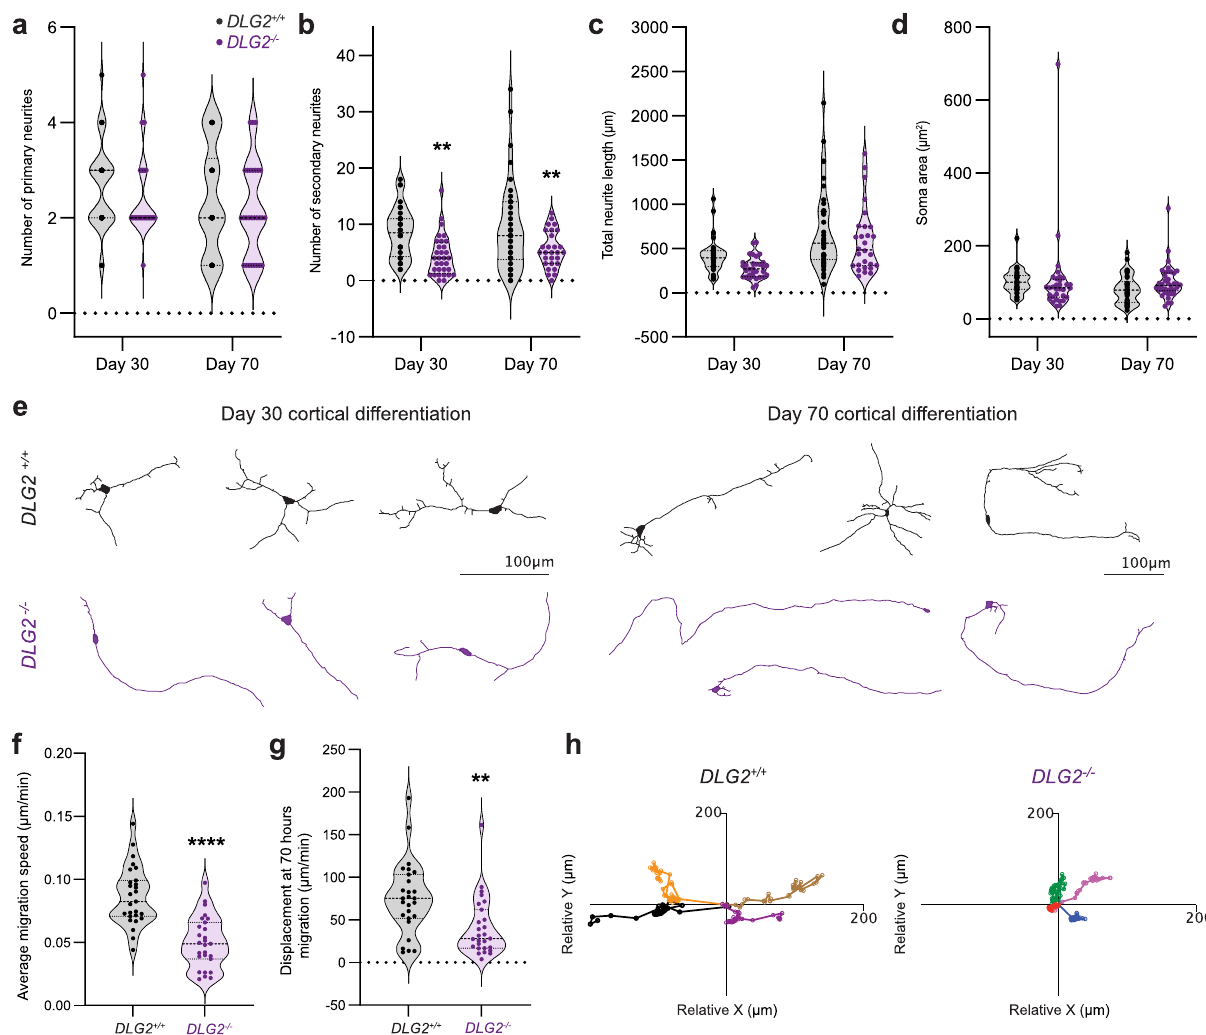
Fig. 3 DLG2 − / − lines display de fi cits in neuron morphology & migration. a The number of primary neurites (projecting from the soma). Neither genotype ( F 1,126 = 1.591; P = 0.2095) nor time ( F 1,126 = 2.278; P = 0.1337) had signi fi cant effects the numbers of primary neurites. b The number of secondary neurites (projecting from primary neurites). Genotype ( F 1,126 = 18.78, P = 2.97 × 10 − 5 ) had a signi fi cant effect on number of secondary neurites, while time ( F 1,126 = 1.082, P = 0.3003) did not. c The total neurite length. Both genotype ( F 1,126 = 4.568; P = 0.0345) and time ( F 1,126 = 26.33; P = 1.06 × 10 − 6 ) had signi fi cant effects on total neurite length. However, post hoc analysis showed no signi fi cant differences at individual timepoints. d The soma area. Neither genotype ( F 1,136 = ; P = 0.9170) nor time ( F 1,136 = 1.399; P = 0.2390) had a signi fi cant effect on soma area. For a – d WT n = 32, 38 cells from 3 independent experiments, days 30 & 70 respectively; KO n = 32, 28 cells from 3 independent experiments, days 30 & 70 respectively. e Representative traces showing the neuronal morphology. f The average speed of neuronal migration over 70 h, from day 40 of cortical differentiation. DLG2 − / − neurons showed signi fi cantly decreased average migration speed compared to WT ( t 52 = 6.1175; P = 1.26 × 10 − 7 ; n = 27). For f – g both WT & KO n = 27 cells from 3 independent experiments. g The displacement of neurons at 70 h migration. DLG2 − / − neurons showed signi fi cantly decreased displacement compared to WT ( t 52 = 3.244; P = 0.0021; n = 27). h Representative traces of neuronal migration from a given origin over 70 h. Morphology data sets ( a – d ) were analyzed by two-way ANOVA with post hoc comparisons using Bonferroni correction, comparing to WT controls. Migration data sets ( f , g ) were analyzed by unpaired two-tailed Student ’ s t test. Stars above bars represent, ** P < 0.01; **** P < 0.0001 vs. WT control (Bonferroni-corrected for morphology analyses). Source data are provided as a Source Data fi